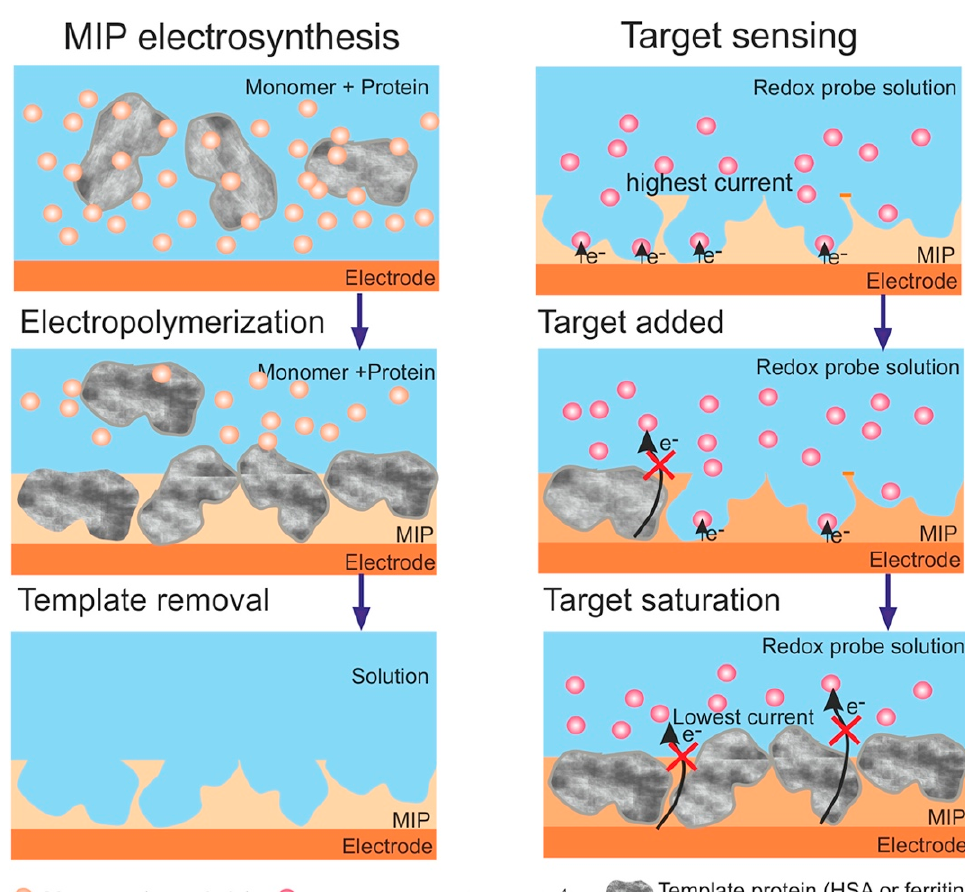
Figure 9. Schematic diagram of the surface-imprinted polyscopoletin nanofilm and its use for protein detection. Reprinted from [84] with permission from Stojanovic et al.